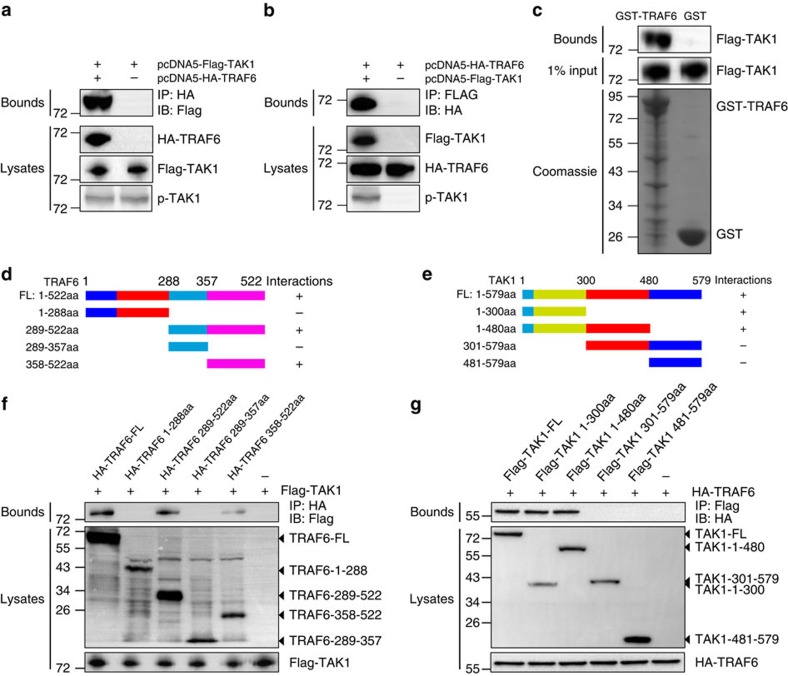
TRAF6 regulates TAK1 through direct physical interaction.(a,b) HEK293T cells were co-transfected with pcDNA5-FLAG-TAK1 and pcDNA5-HA-TRAF6. After 48 h, cells were harvested, and cellular lysates were subjected to IP with antibodies against HA (a) or FLAG (b). (c) GST–TRAF6 or GST was retained on glutathione–Sepharose beads, incubated with immunopurified Flag-TAK1 from HEK293T cells and then immunoblotted with the antibody against FLAG. (d,e) Schematic representation of the full-length and deletion mutants of TRAF6 (d) and TAK1 (e) used for determining the interaction domains. (f) Western blots performed using a FLAG or HA antibody after co-IP of the full-length or truncated forms of TRAF6 from HEK293T whole-cell lysates using the anti-HA antibody. (g) Representative western blot performed with a FLAG or HA antibody after co-IP of the full-length or truncated sequences of TAK1 from HEK293T whole-cell lysates with an anti-FLAG antibody.